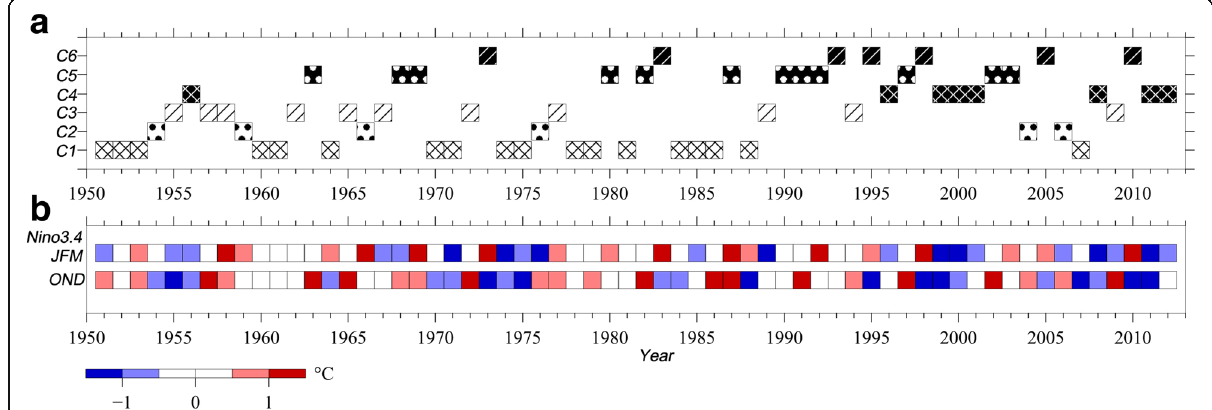
Fig. 5 Long-term variability in the seasonal march pattern of the summer rainy season. a A diagram of each cluster for the period of 1951 – 2012. b ONI (the 3-month mean SST anomalies averaged in Niño 3.4) for January – March (JFM) and for October – December